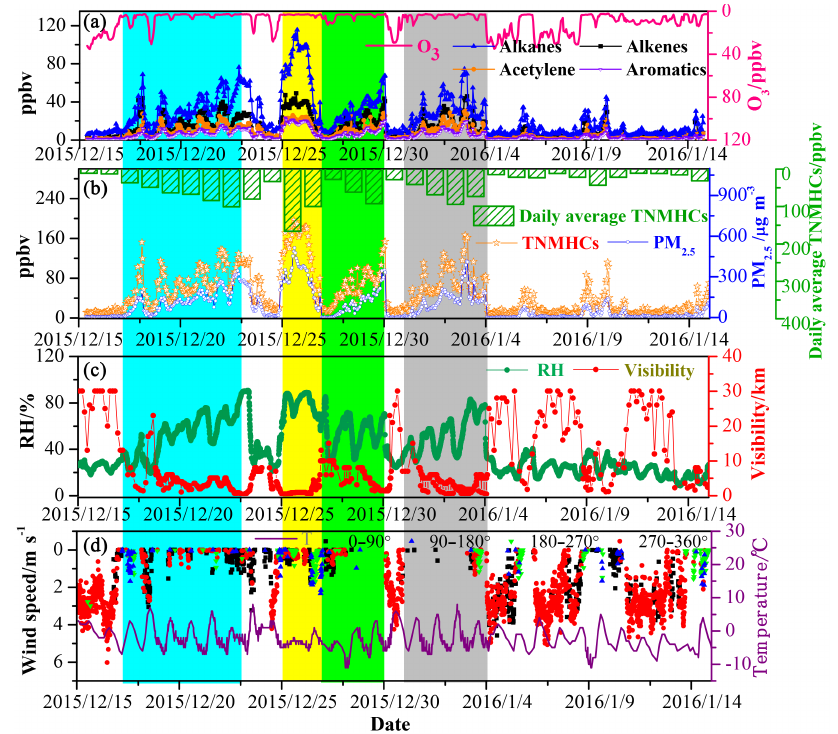
Figure 1. Time series of measured NMHCs, PM 2 . 5 , O 3 , visibility, relative humidity, temperature, and wind speed. The shaded areas indicate pollution episodes: 17–22 December (cyan), 25–26 December (yellow), 27–29 December (green), and 31 December–3 January (light